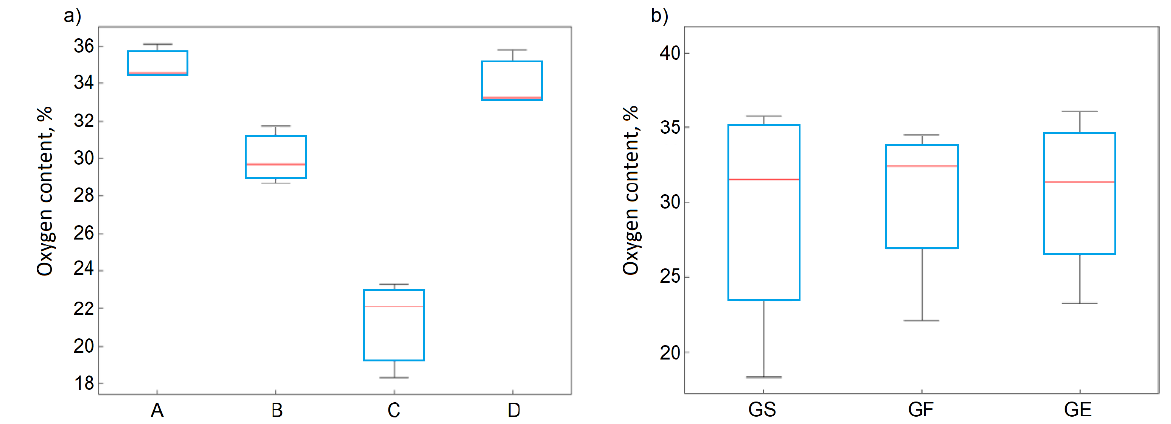
Figure 2. Box plots for oxygen concentrations depending on the ( a ) method and ( b ) precursor material. During the graphite oxidation process, the interlayer distances between the graphene layers increased more than two-fold, from approximately 0.336 nm (band 002) to 0.8184 nm (band 001), as a result of adding oxygen groups between layers and adding oxygen groups at the edges of the layers. The graphite oxides obtained using method A were characterized by the largest d 001 interlayer distances (0.8013–0.8184 nm) and the smallest dimensions of graphene layers L a (26–28 nm). The statistical significance of this information was confirmed by ANOVA, and the results for both d 001 and L a are presented in Figure 3a,b, re- spectively. It was observed that the larger dimensions of the graphene layers in the graphite, the larger dimensions were in the obtained GO, regardless of the oxidation method.